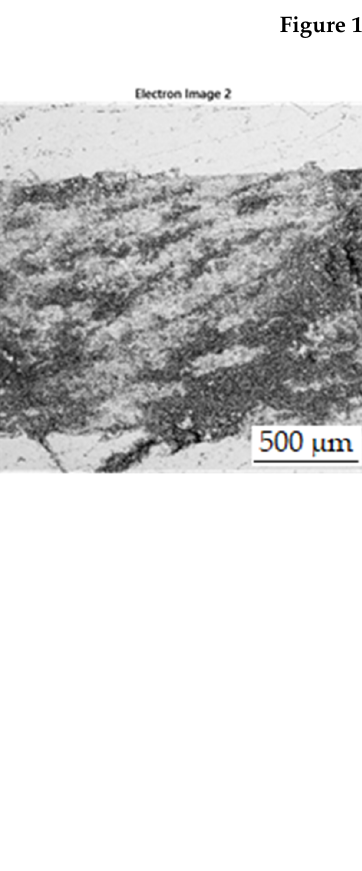
Figure 14. EDS map of the distribution of the elements of wear track in alloy in the reduced state.